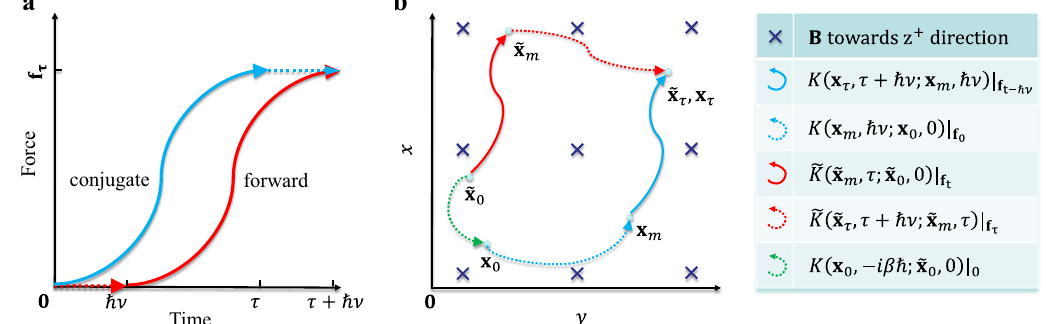
Fig. 3 Illustrative diagram of the emergence of the magnetic fl ux term in the free energy equality. a Schematic diagram of the forced protocol in Eq. (6). The blue (red) lines denote the force along with the forward (conjugate) propagators, and the dashed lines correspond to the measurement operator in the two-point work measurement scheme 24 . The symbol ℏ is the Planck constant, ν is the parameter in the characteristic function χ ( ν ), τ is the time interval of the driving process. b A schematic diagram of the propagators in the work characteristic function. The blue (red) lines are the forward (conjugate) propagators. The two solid-line propagators are from the unitary operators. The dashed red and blue (green) lines are propagators from work measurements (initial distribution 36 ). All propagators contain multiple quantum paths and are idealized as a line. The magnetic fl ux through the closed- loop leads to a new term in the free energy equality Eq. (4). The symbols and expressions for the propagators K are listed in the legend, where the tilde variables are those for the conjugate process and B is the magnetic fi eld. The expressions for the propagators K are in the Methods section. The x is the position coordinate and f is the forced parameter, with their subscripts denoting time.